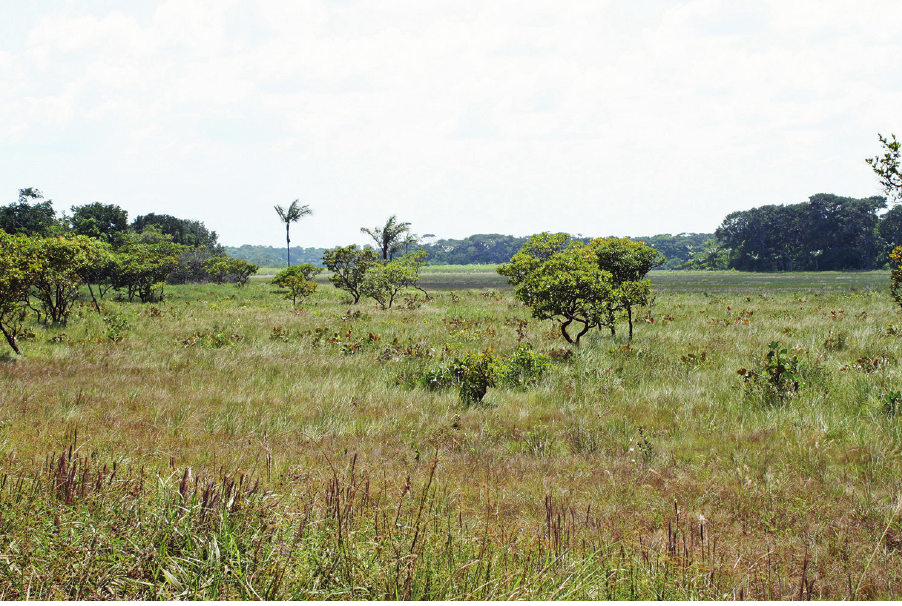
Figure 37. Coastal savanna habitat (Sinnamary, French Guiana).